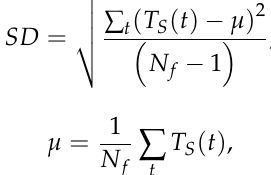
Figure 10. Graphs of the most common wavelets used for continuous analysis: ( a ) Morlet, ( b ) a Gaussian derivative, and ( c ) a Mexican hat.